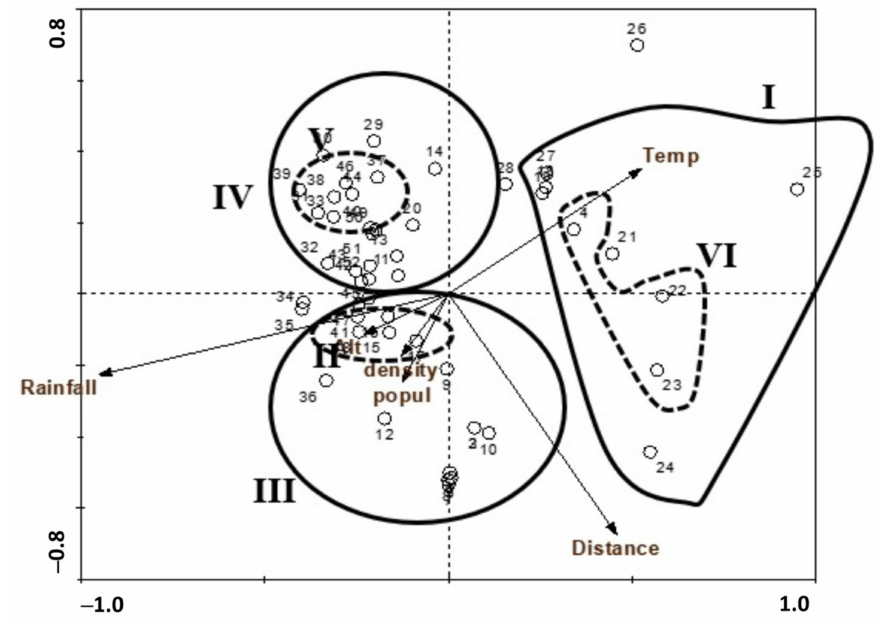
Figure 6. CCA biplot ordination of the sampled stands with environmental